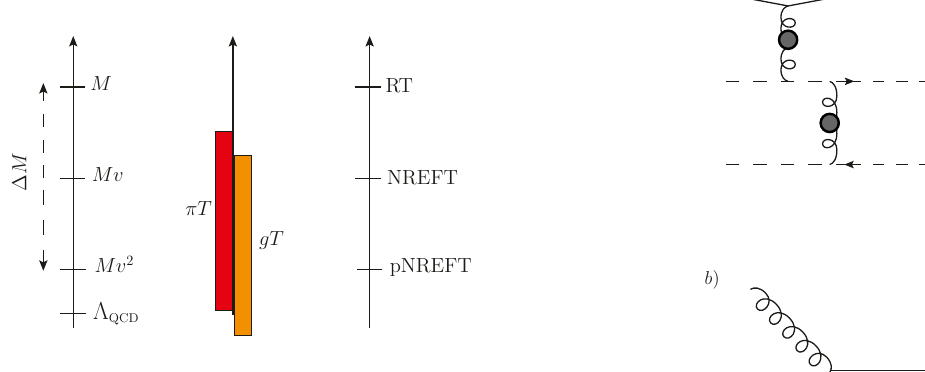
Figure 1 . Left: non-relativistic and thermal scales. In the weak coupling regime the thermal scales are arranged as (cid:25)T (cid:29) m D . Figure adapted from ref. [29], RT stands for relativistic theory. Right: Landau damping and gluodissociation processes, i.e. 2 ! 2 scattering process with light plasma constituents and 2 ! 1 process that involves a thermal gluon. In diagram a), dashed lines stand for coloured scalars and the gray blob for a resummed HTL gluon propagator. In diagram b), the solid line stands for a coloured scalar pair in the singlet con(cid:12)guration whereas the double solid line for a colour octet